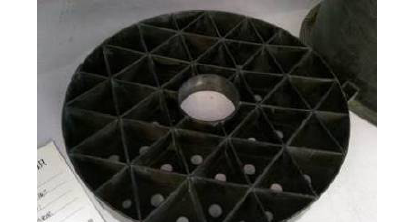
Fig. 6 Grid forming die.